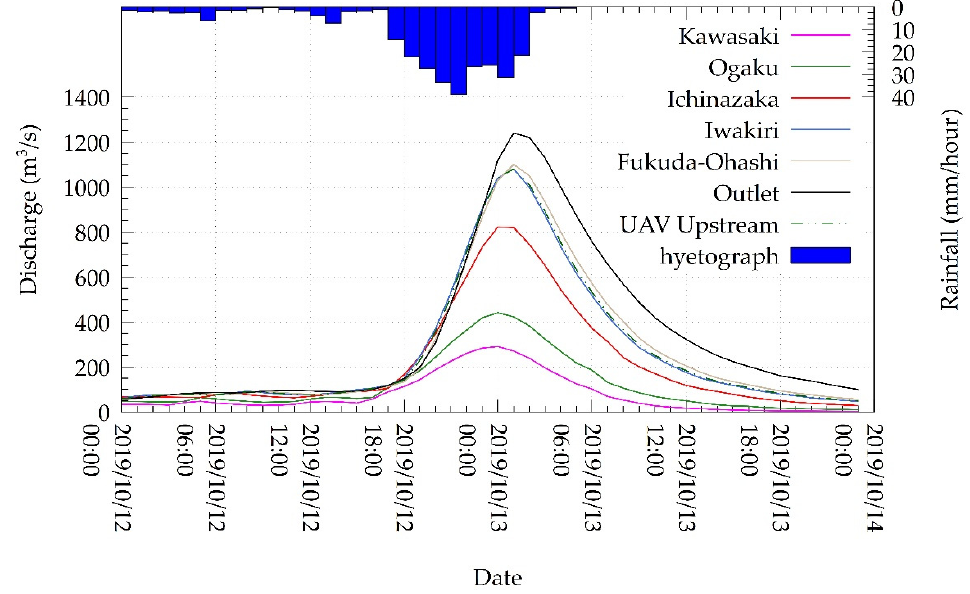
Figure 7. RRI simulated discharges in all the water level gauge stations shown in Figure 1b, in the UAV upstream section, and in the outlet.